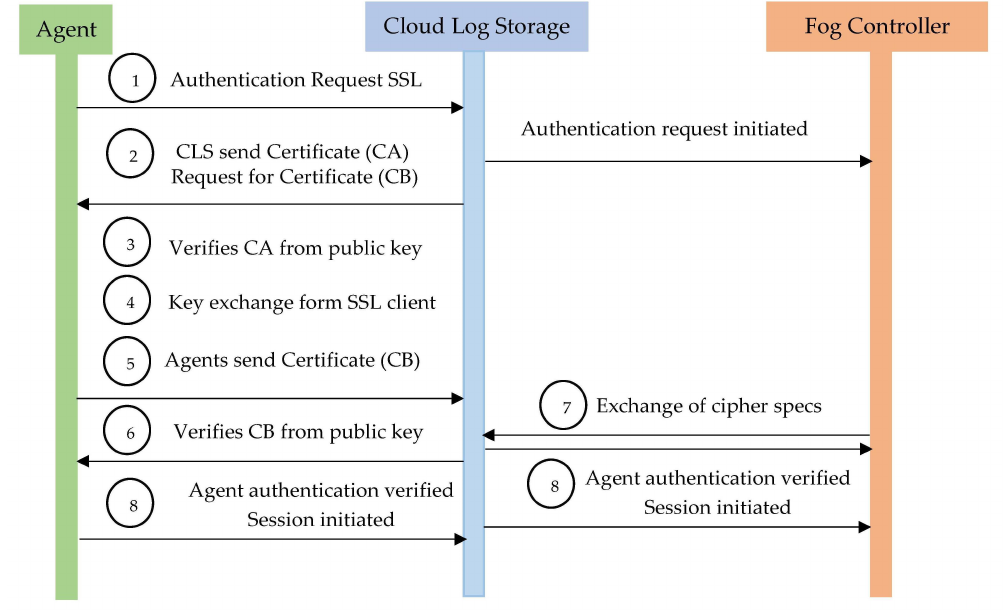
Figure 14. SSL mutual authentication amid agent, cloud and fog node